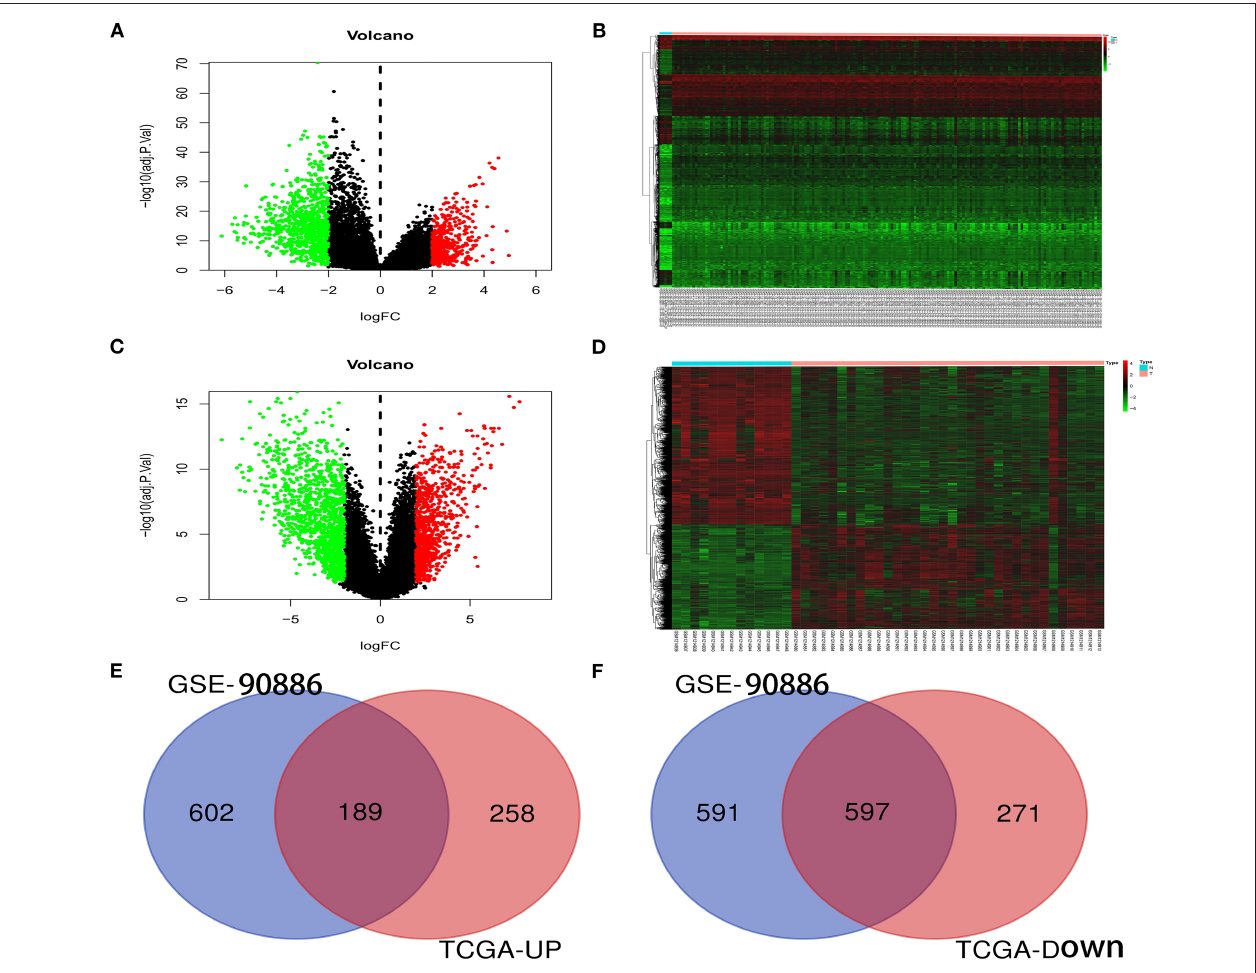
FIGURE 1 | Identification of differentially expressed genes. (A,C) The volcano plots of DEGs in TCGA and GSE90886 datasets. Green and red represent the significantly downregulated and upregulated genes, respectively. The black dot represents genes with no significant difference. (B,D) The heat maps of the expression of DEGs in the TCGA and GSE90886 datasets. (E,F) The intersection of upregulated and downregulated genes in the 2 datasets, respectively. DEG, Differentially expressed